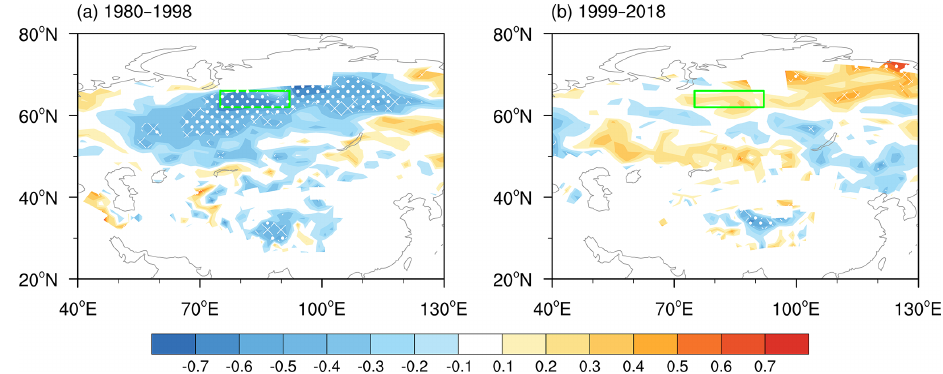
Figure 2. The correlation coefficients between the JJA-mean OWI and AM-mean snow cover (a) from 1980 to 1998 and (b) from 1999 to 2018. The white dots (hatching) indicate that the correlation coefficients exceeded the 95% (90%) confidence level ( t test). The green box represents the key area used to calculate SC WS index. The linear trend is